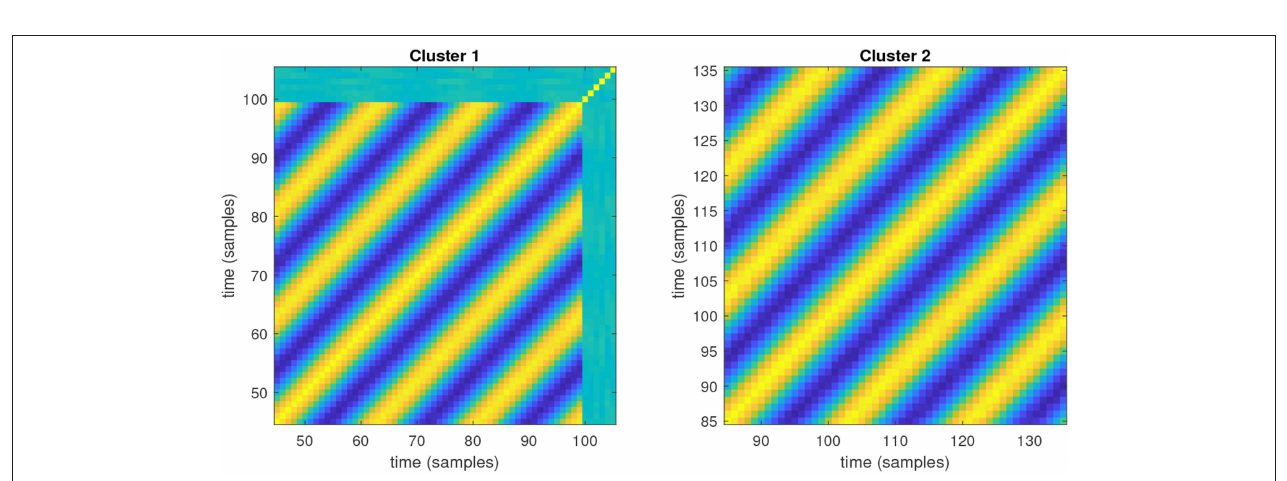
FIGURE 9 | Multi-variate RPs computed on the regions of interest and time intervals reported in Figure 8